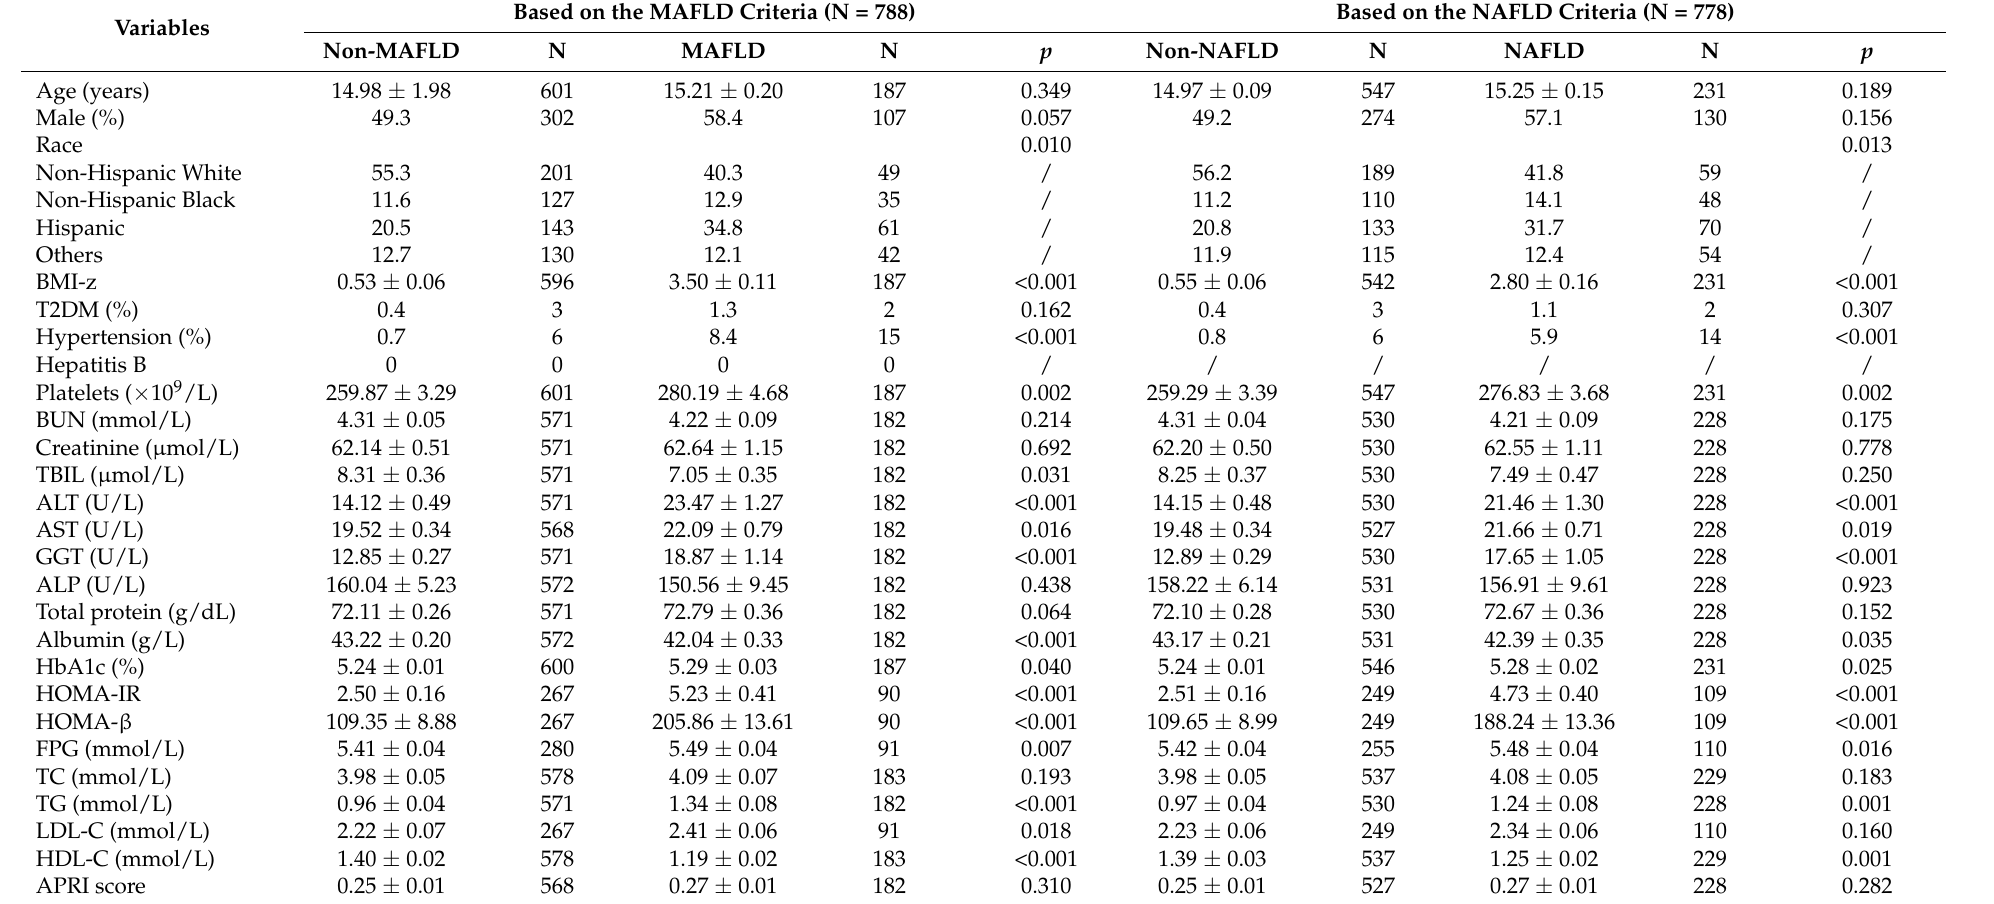
Table 1. Baseline characteristics of subjects in NHANES 2017–2018 by